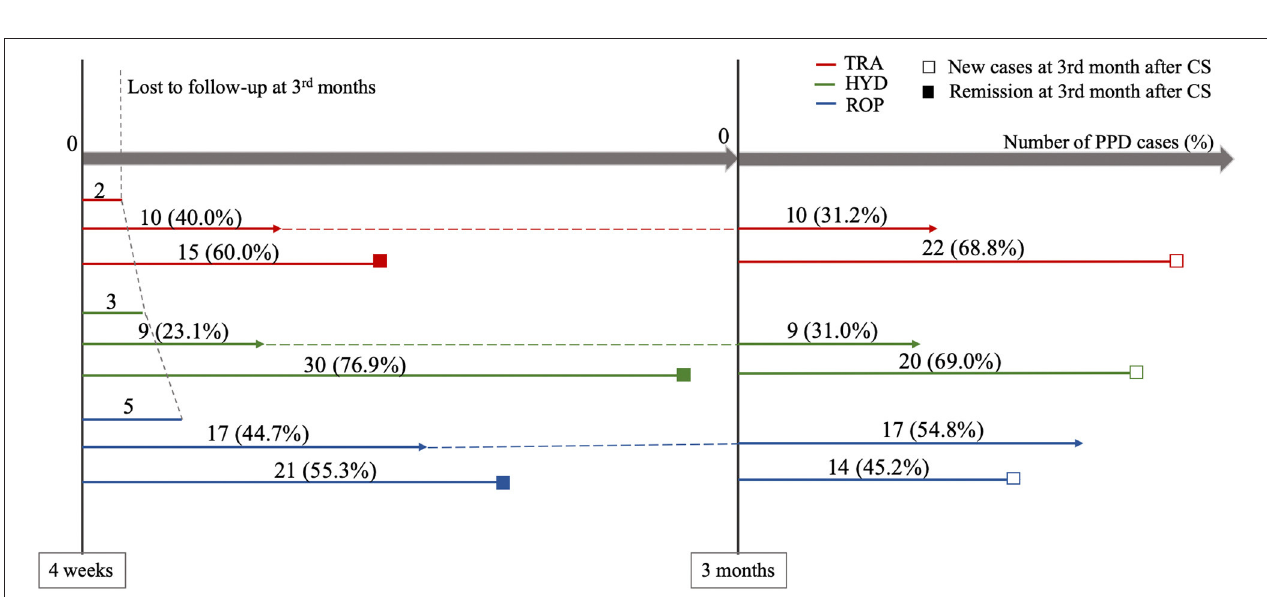
FIGURE 2 | Changes in the incidence of PPD from 4 weeks to 3 months after CS in (A) all patients; and (B) patients at high risk for PPD. P -values were calculated by the χ 2 test and adjusted by Bonferroni correction. * p < 0.05 vs. HYD and ROP groups. PPD, Postpartum depression; TRA, Tramadol PCIA; HYD, Hydromorphone PCIA; ROP, Ropivacaine PCEA; CS, cesarean section.